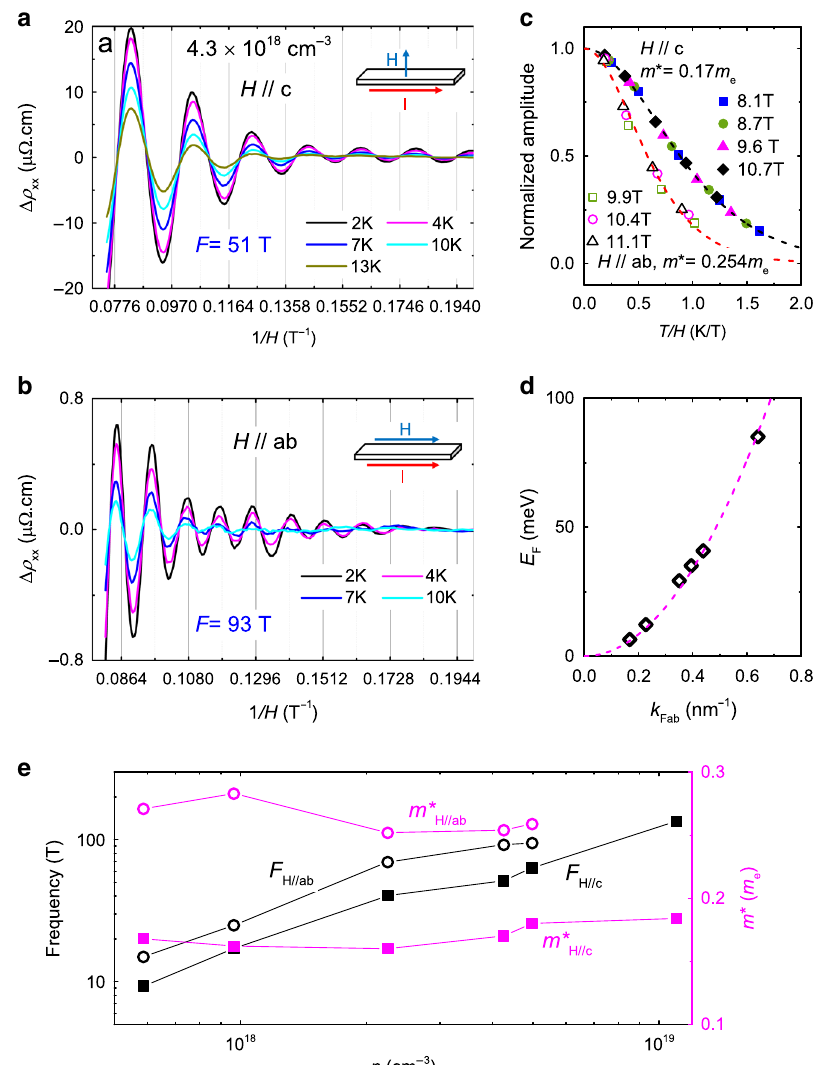
Fig. 3 Shubnikov-de Haas effect for Bi 2 O 2 Se at n ≈ 4.3 × 10 18 cm − 3 . a , b Resistive quantum oscillations as a function of inverse fi eld (1/ H ) with H ∥ c and H ∥ ab, respectively. Δ ρ = ρ − ρ ρ fi tted background of the magneto-resistance. c Normalized amplitude of oscillations as a function of T / H for b where b is a two fi eld directions. The dashed lines are the Lifshitz – Kosevich fi ts. d Fermi energy as a function of the in-plane Fermi wave vector for different samples, suggestive of a conducting band dispersion. The dashed line is a parabolic fi t. e Evolution of the oscillation frequency ( F ) and the effective mass ( m * ) with n in different samples for fi eld along c-axis and ab-plane, respectively. F H ∥ c and F H ∥ ab are denoted by solid black squares and open black circles, respectively. m (cid:1) and m (cid:1) are denoted by solid magenta squares and open magenta circles, H k c H k ab